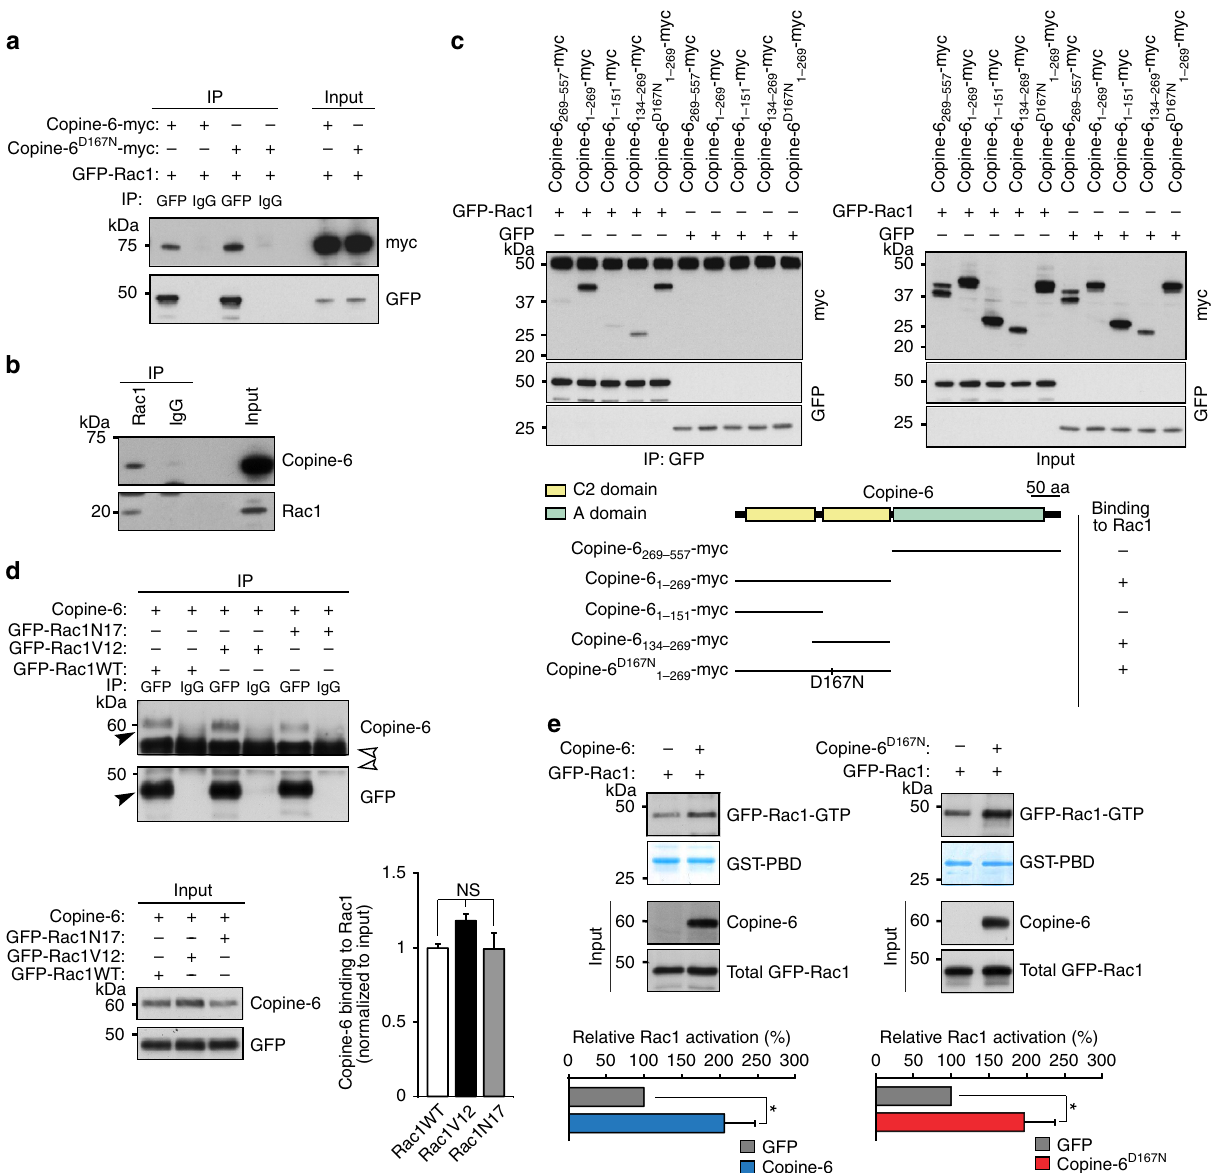
Figure 5 | Characterization of Copine-6 binding to Rac1 and regulation of Rac1 activity. ( a ) COS7 cells were co-transfected with expression constructs encoding GFP-Rac1 and Copine-6-myc or Copine-6 D167N -myc. Rac1 was immunoprecipitated (IP) using anti-GFP antibodies (GFP) or non-immune IgG (IgG) as control. Immunoprecipitates were analysed with anti-myc (myc) or anti-GFP antibodies. ( b ) Hippocampal lysates of 6-week-old mice after immunoprecipitation (IP) with anti-Rac1 antibodies or non-immune IgG. Precipitates were analysed with anti-Copine-6 (Copine-6) or anti-Rac1 (Rac1) antibodies. Input represents western blottings of hippocampal lysates. ( c ) COS7 cells were co-transfected with expression constructs encoding myc-tagged Copine-6 deletion mutants together with GFP-Rac1 or GFP (as negative control). Left: analysis of anti-GFP immunoprecipitates (IP) using antibodies to myc or GFP. Right: western blot analysis of COS7 cell lysates before immunoprecipitation. Bottom: schematic illustration of deletion constructs and summary of results. ( d ) COS7 cells were co-transfected with Copine-6 and GFP-Rac1 (GFP-Rac1WT), a dominant-negative form of Rac1 (GFP-Rac1N17) or a constitutively active form (GFP-Rac1V12). Immunoprecipitations (top) were performed using anti-GFP antibodies (GFP) or non-immune IgG (IgG) as a control. Immunoprecipitates were analysed with antibodies to Copine-6 or GFP as indicated. Black arrowheads indicate Copine-6 and GFP-Rac1, respectively; open arrowheads indicate IgG heavy chains. Bottom: western blot analysis of COS7 cell lysate (left; input) and quantification of the relative binding of Copine-6 to the different Rac1 mutants (right). Data are mean ± s.e.m. from n ¼ 3 experiments. NS, nonsignificant. P 4 0.05 by one-way ANOVA with Tukey’s post-hoc test. ( e ) Determination of the relative amount of activated Rac1 (Rac1-GTP) using GST-PBD-mediated precipitation from COS7 cells co-expressing GFP-Rac1 together with empty vector (as negative control), Copine-6 (left) or Copine-6 D167N (right). Western blotting of cell lysates before GST-PBD precipitation (input) is shown and was used for normalization of the quantification (bottom). Data are mean ± s.e.m. from Copine-6: n ¼ 4 cultures; Copine-6D167N: n ¼ 5 cultures. * P o 0.05 by Student’s t -test. NATURE COMMUNICATIONS|7:11613|DOI: